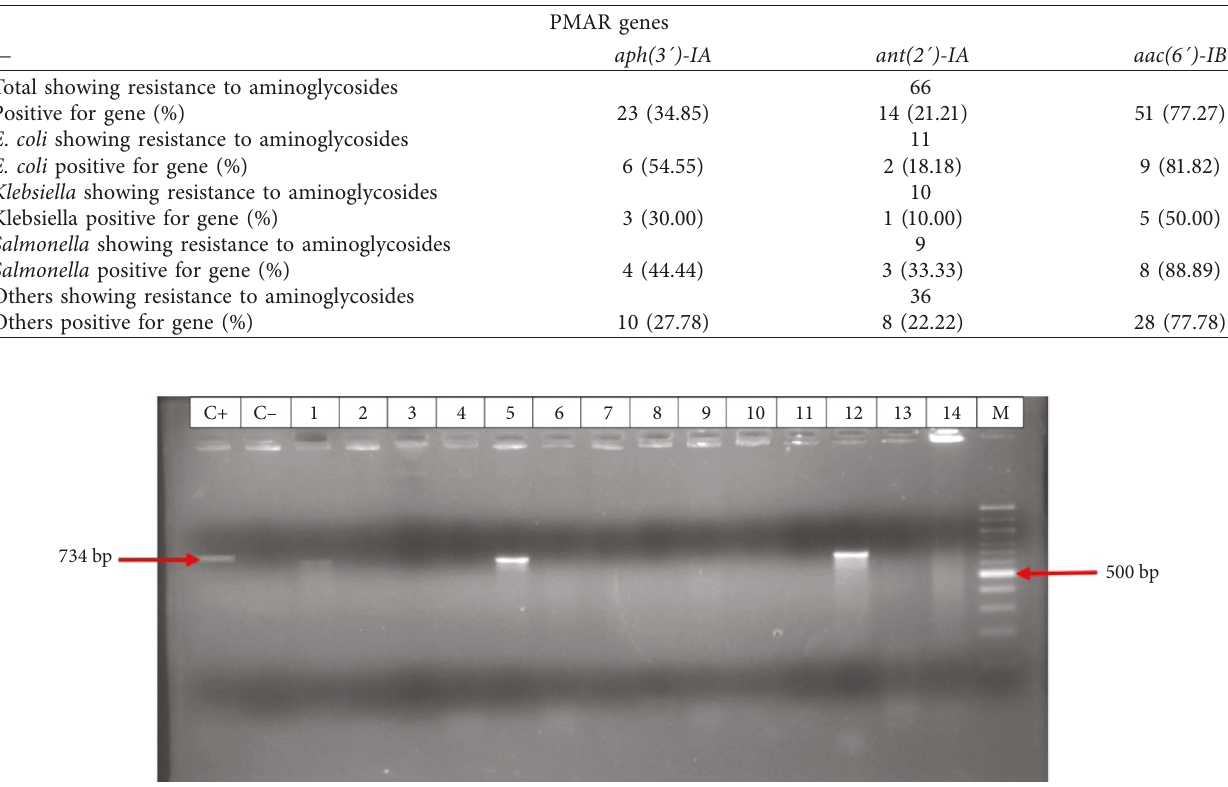
)-IA gene fragment at ′